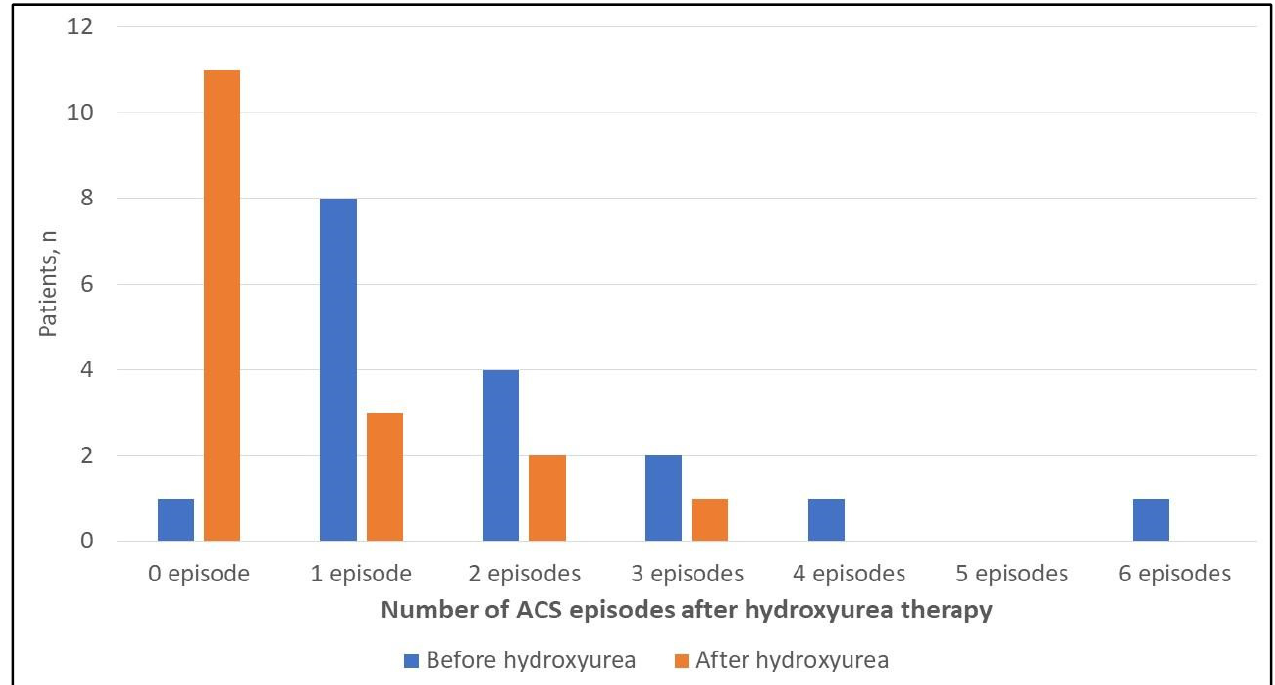
Figure 2. Clustered bar chart illustrating the difference in ACS episodes frequency before and after hydroxyurea therapy [17 patients]. ACS, Acute Chest Syndrome. Table 5. Univariable binary logistic regression analysis of potential factors associated with developing recurrent